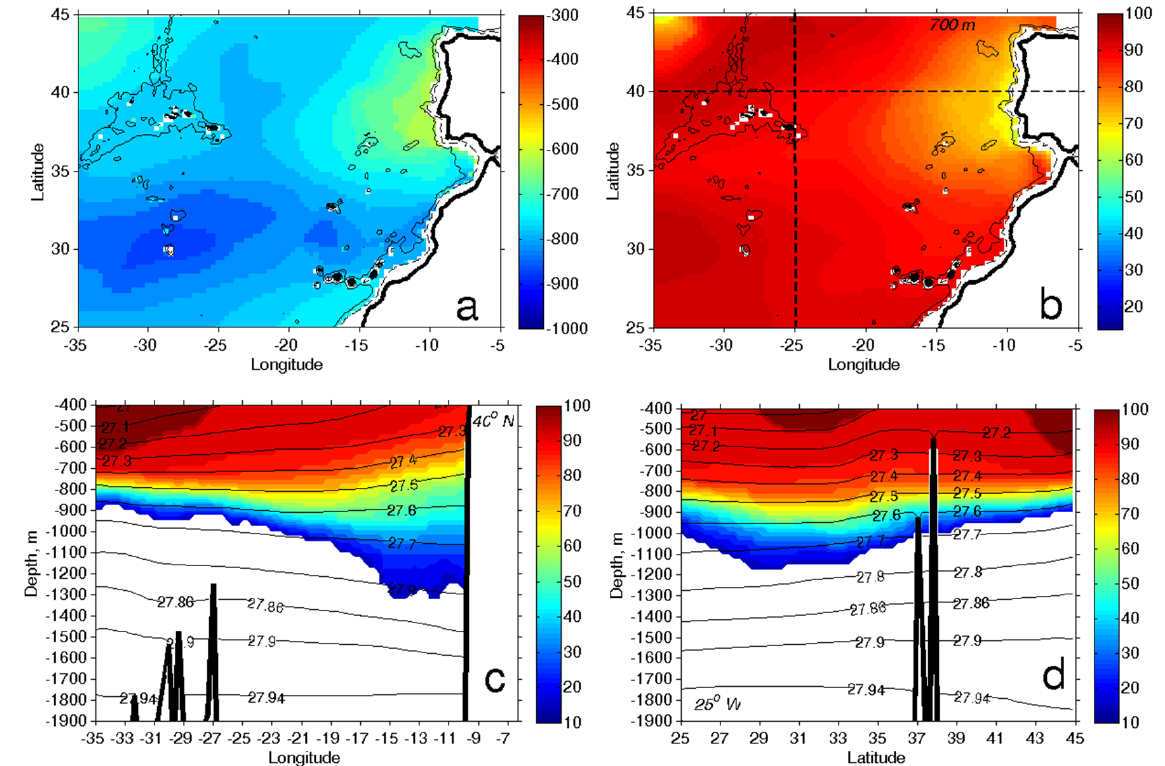
Figure 4. NACW: (a) depth of 50% of NACW content. (b) NACW content (%) at 700m. Isobaths of 500 and 2000m are marked in dashed and solid black lines, respectively. Zonal and meridional sections, presented in panels (c) and (d) , are marked with dashed black lines. (c) zonal section of NACW content (%) along 40 ◦ N; (d) meridional section of NACW content (%) along 25 ◦ W. Solid black lines are neutral density